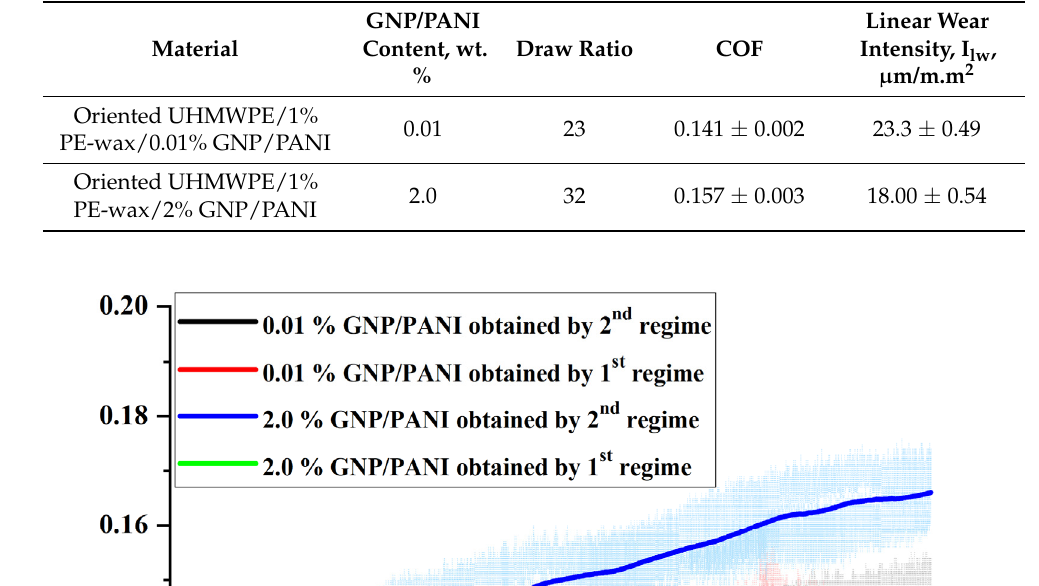
Table 8. Tribological properties of isotropic UHMWPE, virgin-oriented UHMWPE film, oriented